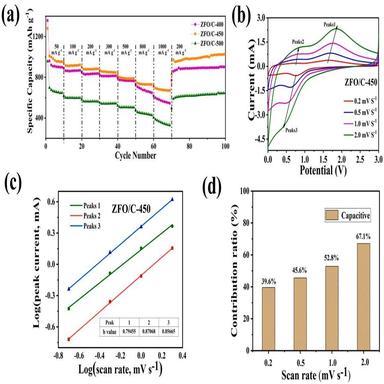
(a) Rate capability of the three electrodes; (b) CV curves of ZFO/C-450 at different scanning rates;(c) Log(ν) vs log(ip) at different peaks of ZFO/C-450 (inset table is the value of b equal to the results of the fitting slope); (d) Capacitance contribution of ZFO/C-450 at different scan rates.